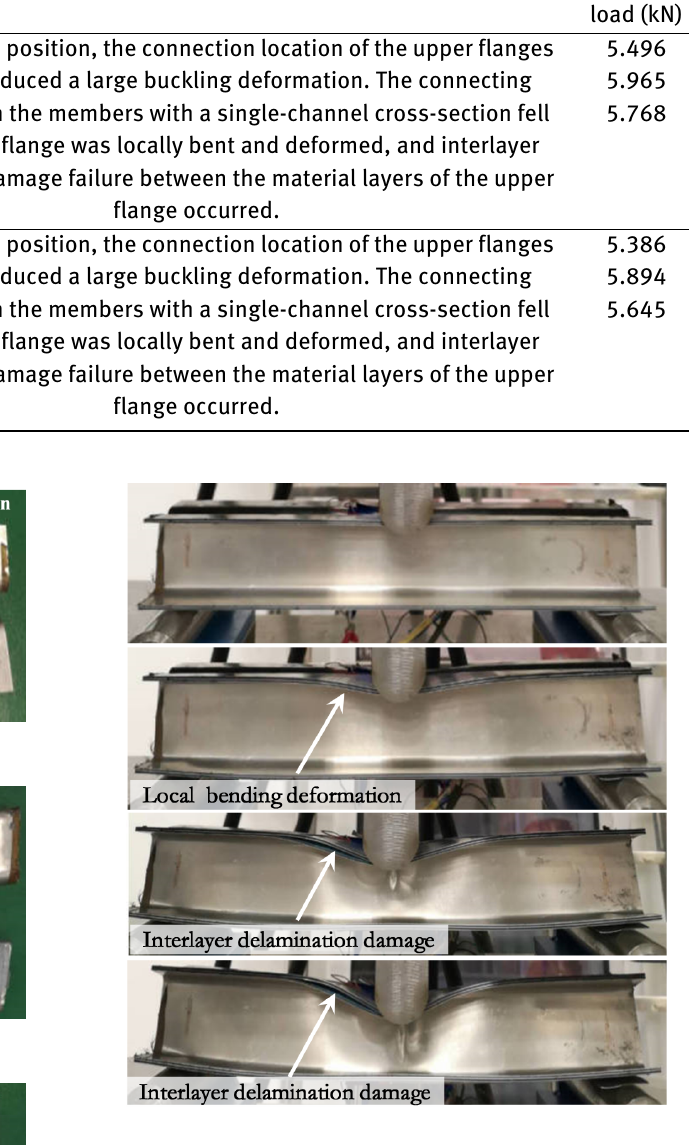
Figure 6: Deformation and failure evolution process of double- channel CARALL